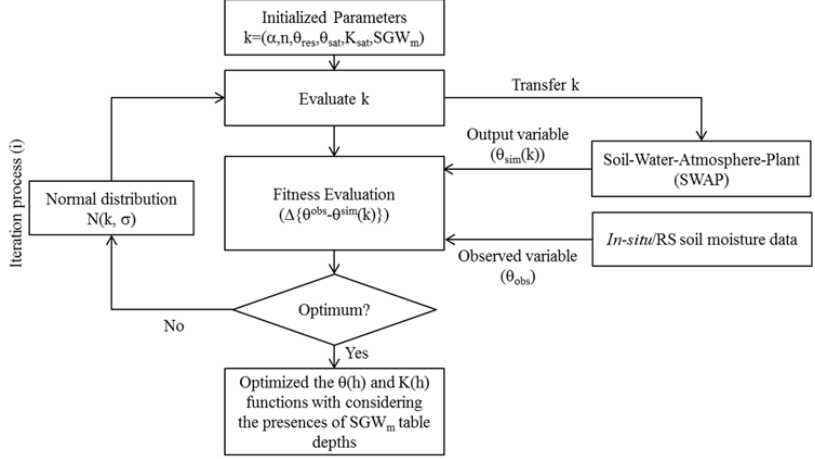
Figure 1. Schematic diagram of the newly developed dynamic ground water (DGW) data assimilation scheme.